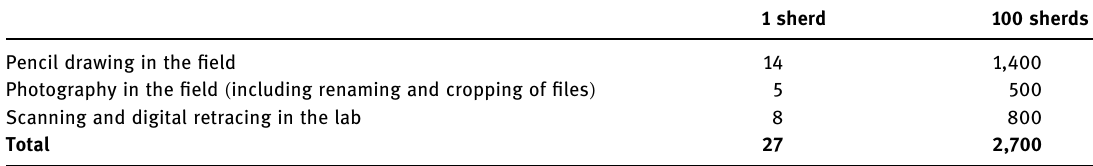
1 sherd 100 sherds